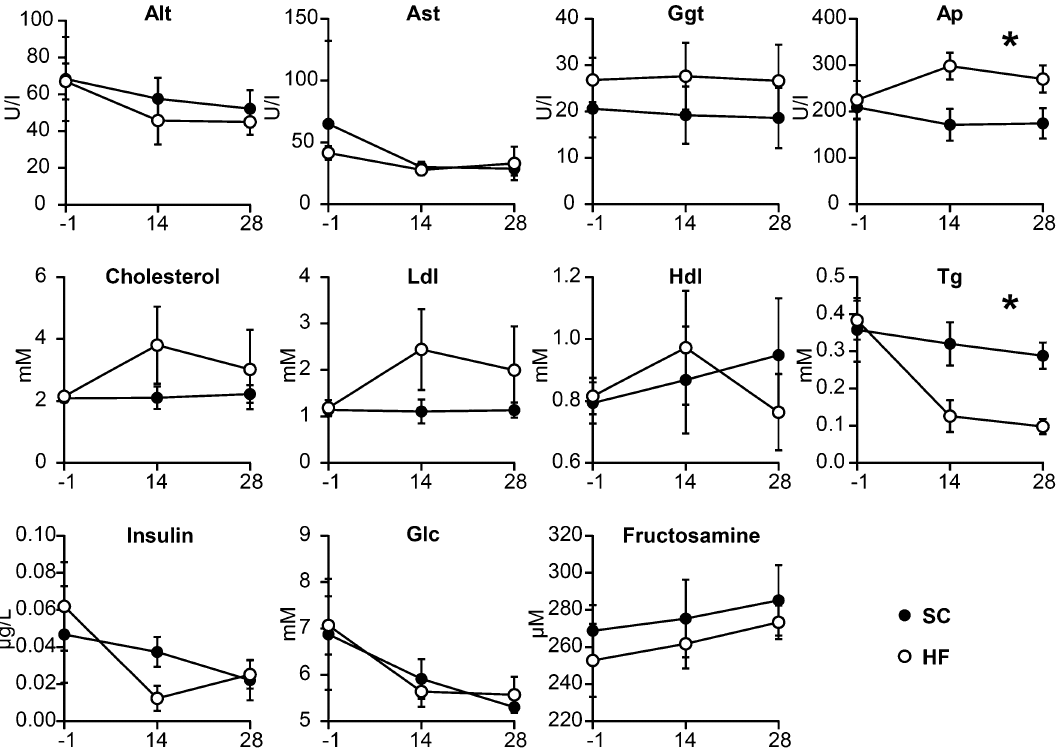
Figure 1. Biochemical characteristics between standard chow (SC) and high-fructose (HF) pigs. HF pigs had higher alkaline phosphatase (Ap) and lower triglyceride (Tg) levels during the study. For other abbreviations see main test. X-axis depicts days relative to study start. Values are mean ± SD. Groups were compared by AUC and significant differences are indicated * p < 0.05, Student’s